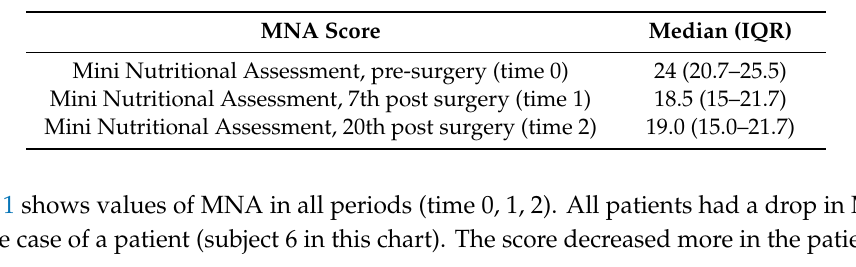
Table 2. Mini Nutritional Assessment (MNA) score (time 0, 1, 2).